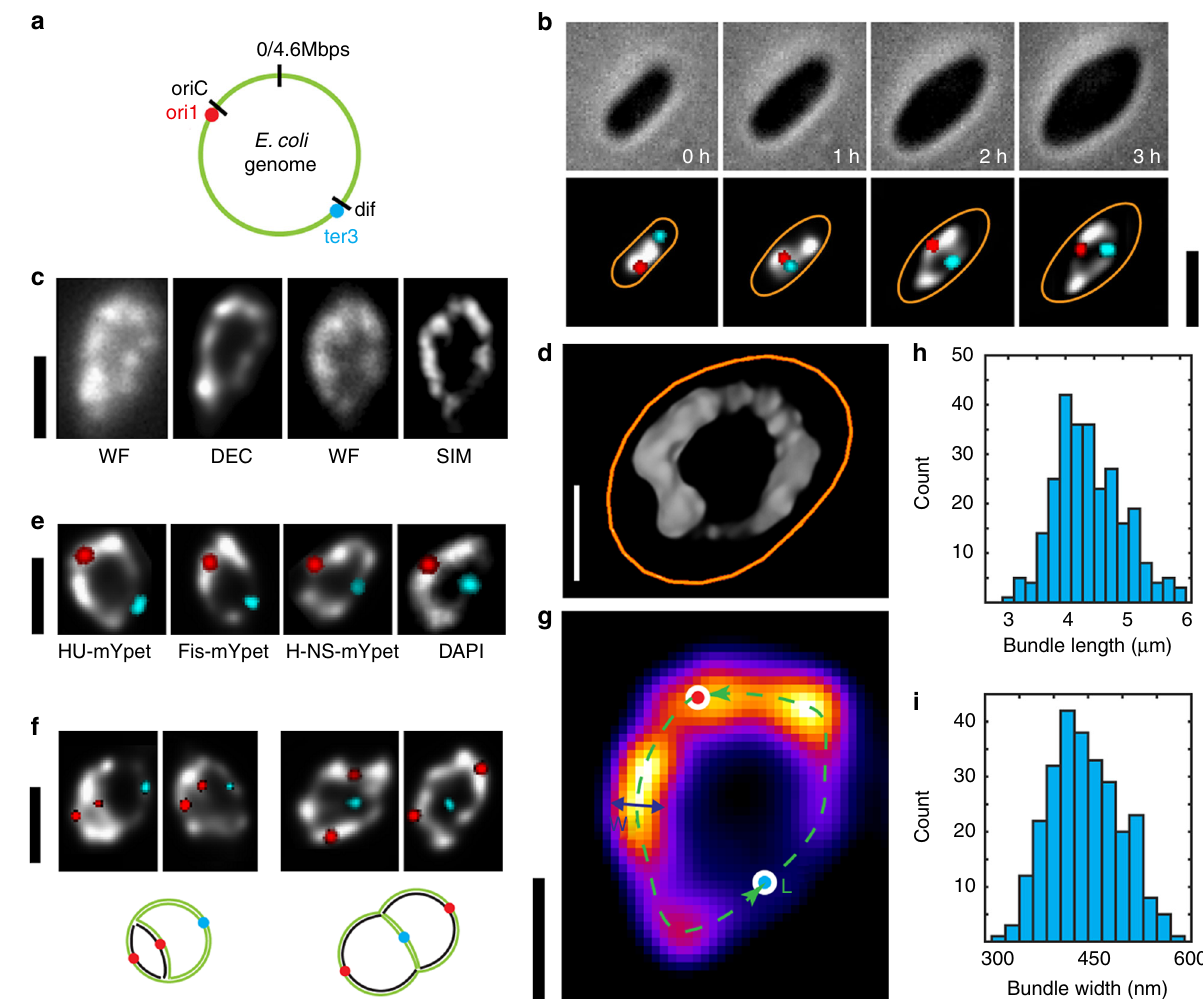
Fig. 1 The circular E. coli chromosome exhibits a toroidal donut-shape that can be visualized upon cell expansion. a Schematic of a E. coli genome. Two FROS markers are shown in red (Ori1 marked by lacO arrays, targed by LacI-mCherry) and cyan (Ter3 marked by tetO arrays, targeted by TetR-mCerulean). b Time-lapse fl uorescence images of an E. coli ( dnaC2(ts) allel) cell growing into a lemon shape at 40 °C under A22 treatment. Top panel, phase contrast image; bottom panel, overlay of Ori focus (red) and Ter focus (cyan) on a grey-scale deconvolved image of the chromosome labeled by HU-mYPet. Time is indicated in hours. c Fluorescence images showing two opened circular chromosomes captured by different methods. Left: WF, wide- fi eld image, and DEC, deconvolved image of that WF. Right: WF and SIM, structured-illumination microscopy image of that WF image. d Donut-shape chromosome of E coli , as imaged in 3D-reconstructed SIM. Orange outlines the cell contour. e Similar donut-shape chromosome images are obtained for different DNA-binding fl uorescent labels (HU-mYPet, Fis-mYpet, H-NS-mYPet, DAPI; all DEC images). f Fluorescence images of early (left) and late (right) stages of DNA replication of circular chromosomes. Bottom: cartoon illustrations; black strands indicate newly replicated DNA. g Fluorescent image of a donut-shape E. coli genome shown as a heat map. Indicated are the ridge of the bundle (green dashed line), the oriC and dif genomic loci near the origin and terminus of replication (red and blue dots respectively), and the bundle width (blue line). h Histogram of chromosome bundle lengths measured along the bundle ridge (cf. panel G). n = 269. i Histogram of the average chromosome bundle widths quanti fi ed as the full-width-at-half-maximum of the peak intensity across the donut chromosomes. n = 269. Scale bars in B/C/E/F, 2 μ m. Scale bars in D/G, 1 μ